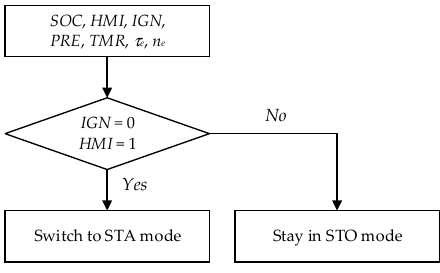
Figure 11. Logics for STA mode decision.